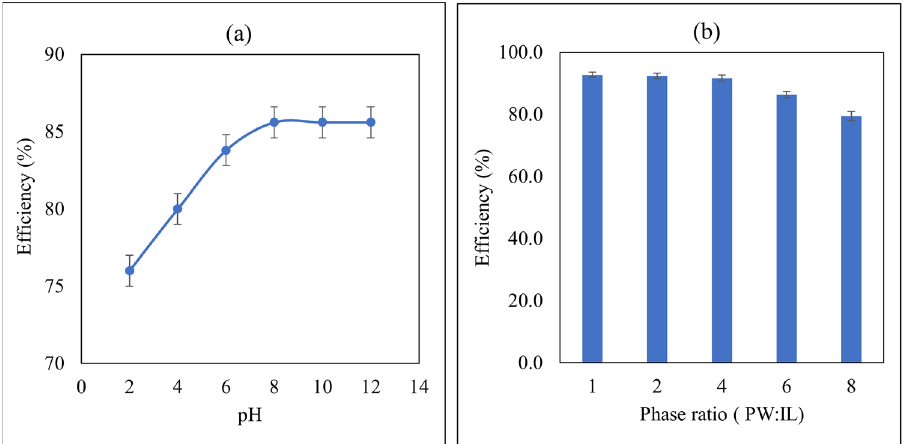
Figure 3. ( a ) Effect of the pH on the removal efficiency of oil by IL4, Initial concentration of oil 500 mg/L, phase ratio (IL:PW) = 1:5, temperature = 25 °C, and contact time = 4 min, with σ = ±3.09 × 10 − 1 %, ( b ) Effect of the phase ratio on removal efficiency of oil from PW by IL4. Initial oil concentra- tion = 500 mg/L, contact time = 4 min, pH = 8 and temperature = 25 °C, with σ = ±3.64 × 10 − 1 %.